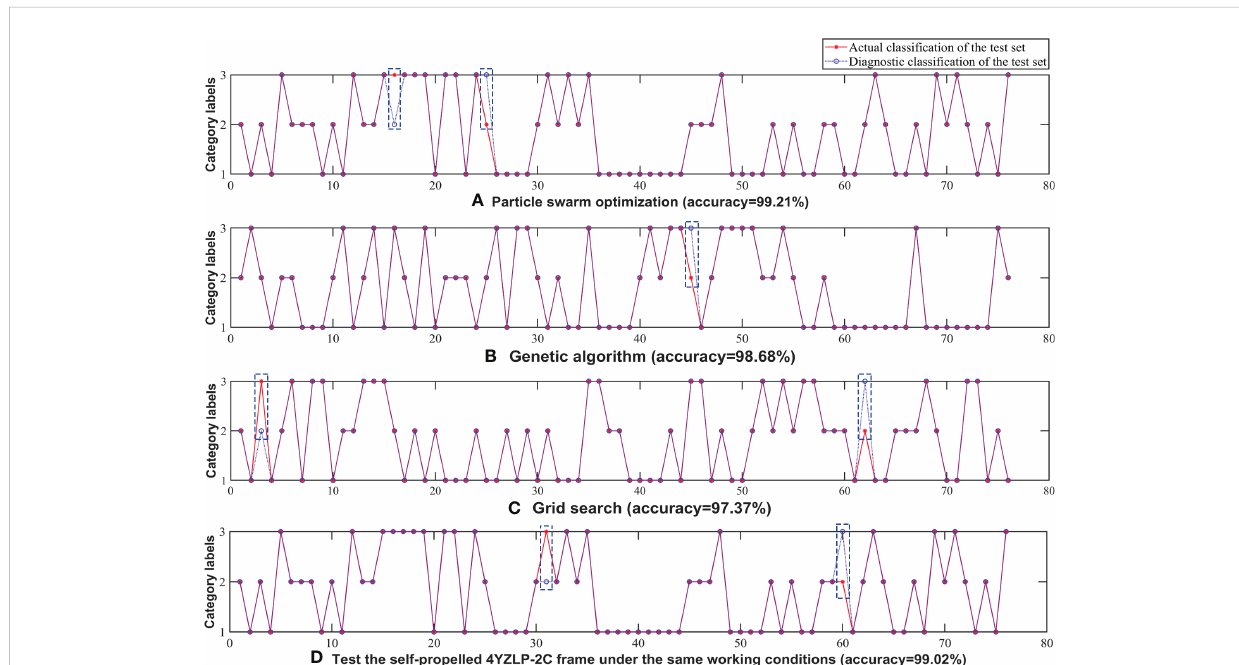
FIGURE 12 Test actual and predicted classi fi cation of data sample sets: (A) Particle swarm optimization (accuracy=99.21%); (B) Genetic algorithm (accuracy=98.68%); (C) Grid search (accuracy=97.37%); (D) Test the self-propelled 4YZLP-2C frame under the same working conditions (accuracy-99.02%).